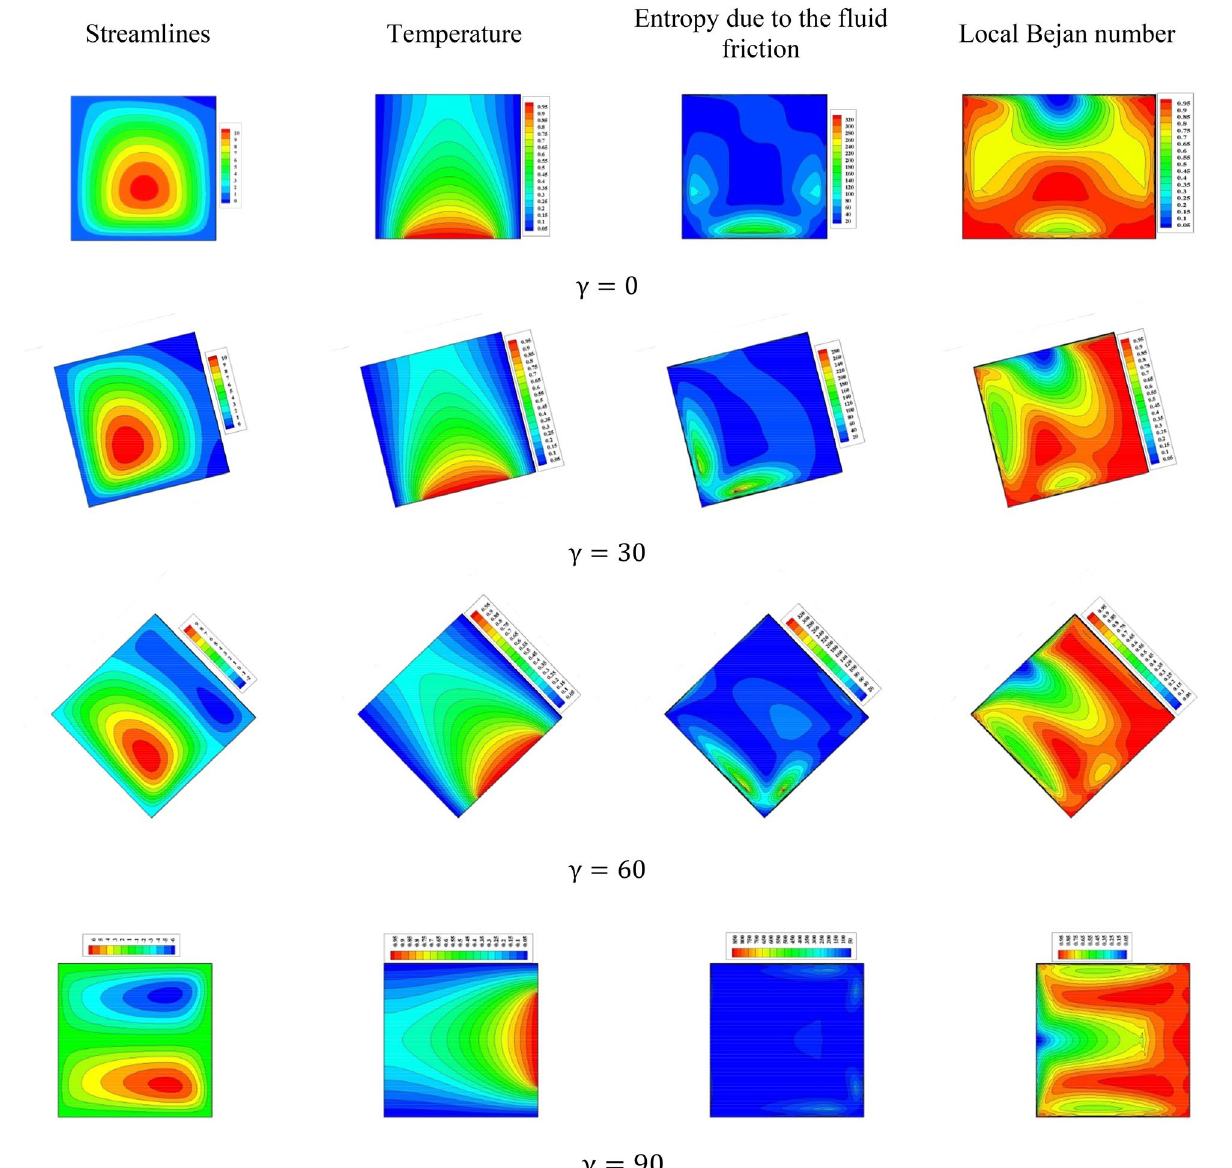
Figure 5. Impacts of the inclination angle γ on the fluid flow, temperature distributions and entropy generation at Ra = 10 5 , Da = 10 − 3 , b = 0.6, d = 0.5, Ma = 1000, β = 0.95, τ = 1, φ = 2%, N = 0.85, Rd = 1, � = 10 − 4